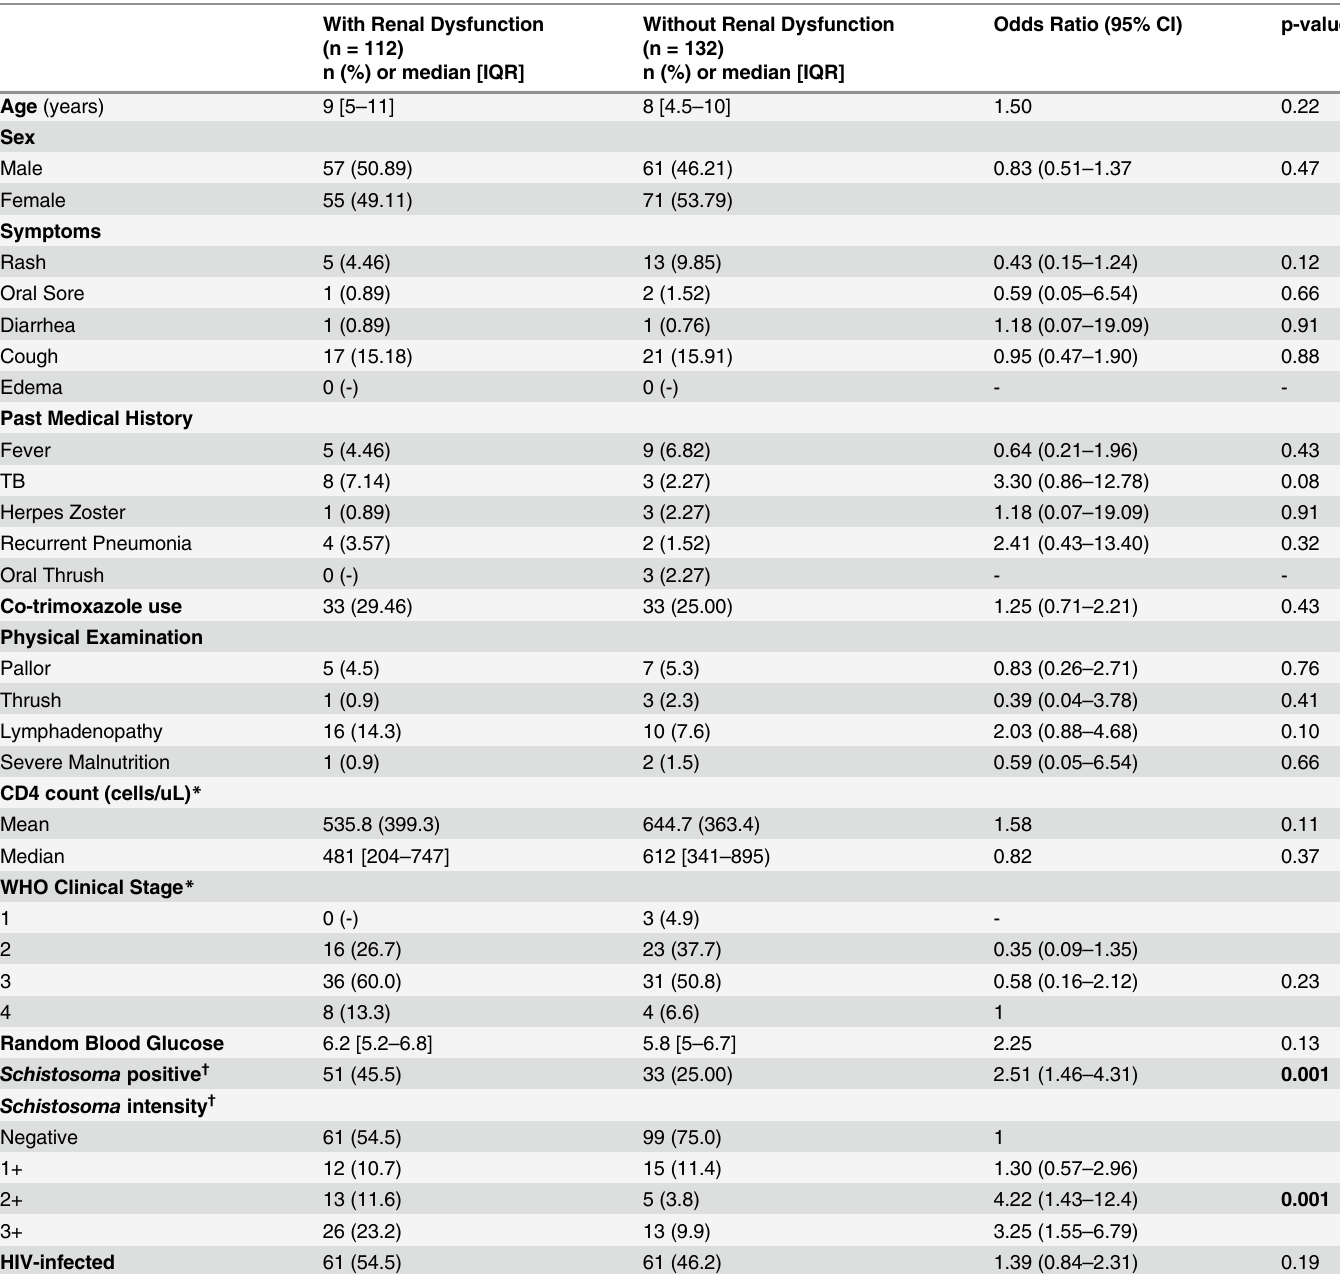
Table 3. Factors associated with renal dysfunction among HIV-infected children and HIV-uninfected siblings by univariable logistic regression. With Renal Dysfunction Without Renal Dysfunction Odds Ratio (95% CI) p-value (n = 112) (n = 132) n (%) or median